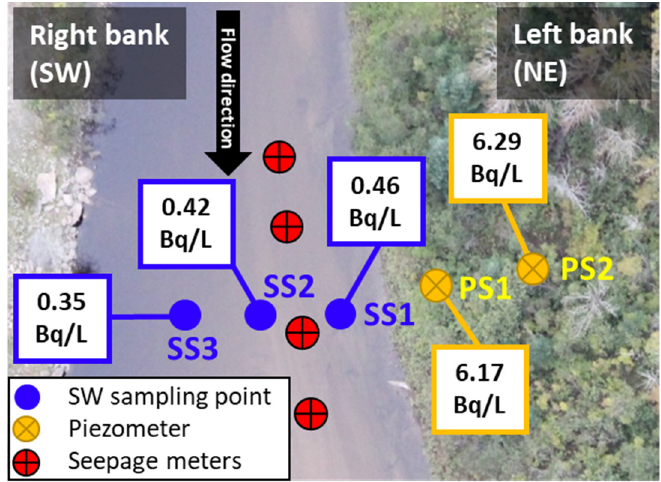
Figure 12. Radon concentration of Sainte-Marguerite River piezometers and SW.